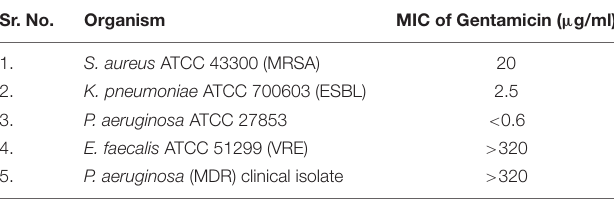
TABLE 5 | MIC for gentamicin – microbroth dilution method. Sr. No.